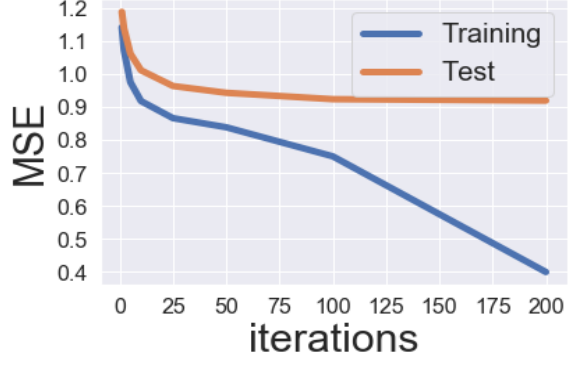
Figure 4. MSE Evaluation Graph for SGD algorithm Figure 4 represents the MSE learning curve of the